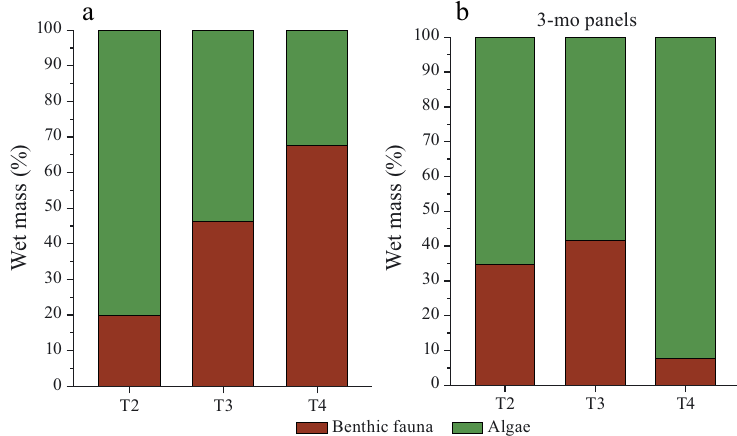
Fig. 4. Percentage contribution of macrofaunal community and algae assem- blages recruited on submersed panels. (a) Assemblages recruited on panels left to colonize for 6, 9 and 12 mo (Group A) (collected at T2, T3 and T4, re- spectively) and (b) panels submersed for 3 mo and collected at T2, T3 and T4